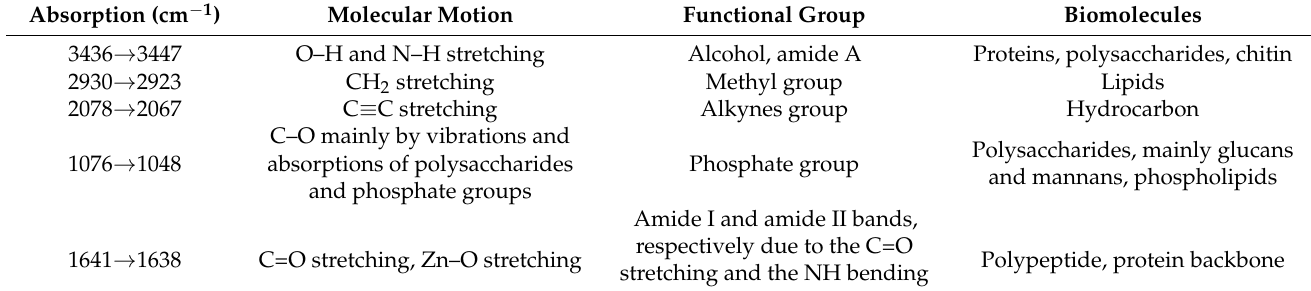
Table 2. Possible involvement of functional groups based on the FTIR analysis.